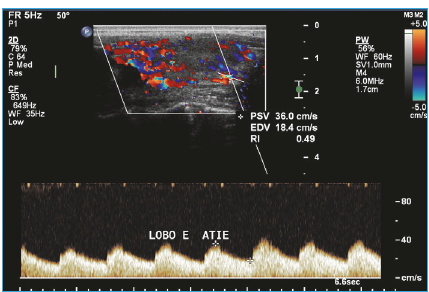
Figure 2: Evaluation of the PSV, EDV, and resistive index of the left inferior thyroid artery via pulsed Doppler